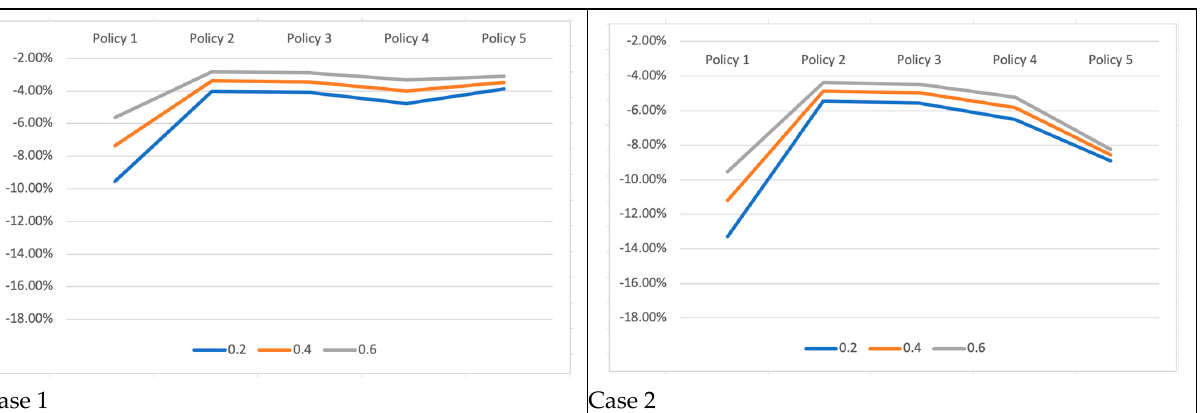
Table 4. Parameters for the switch-o ff policies.